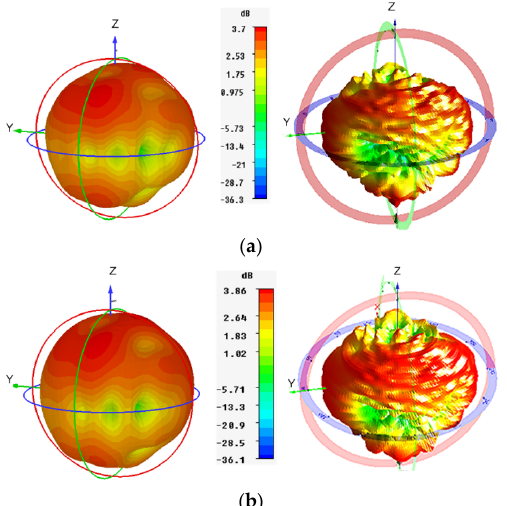
Figure 11. Simulated (left) and Measured (right) 3D Radiation patterns at 5.9 GHz for ( a ) Ant1; ( b )